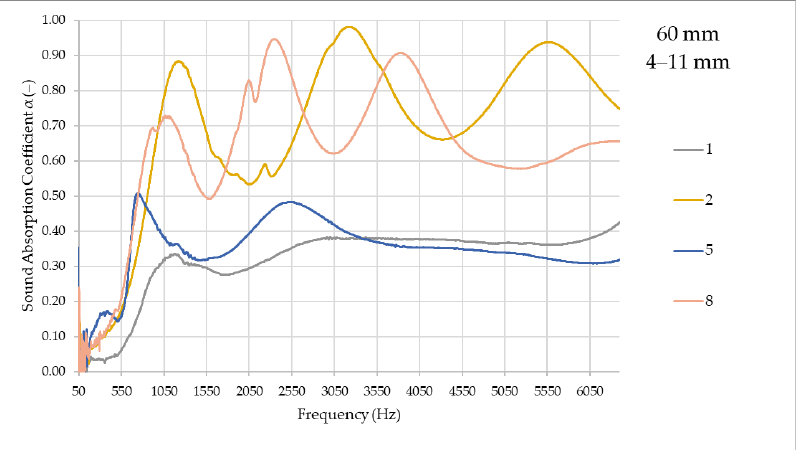
Figure 4. Sound absorption coefficient as a function of frequency of tested specimens of bark panels 4, 6, 7 and 9 with a thickness of 30 mm and a grain fraction of 10 to 30 mm.